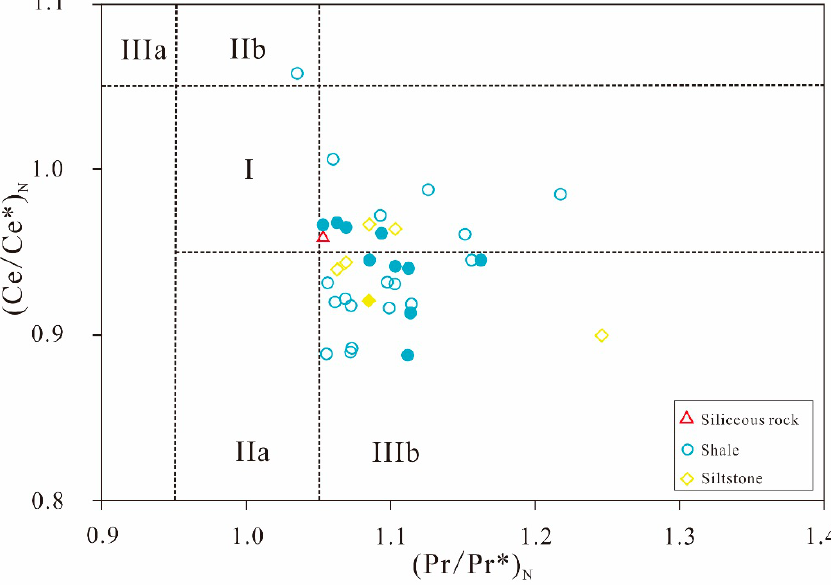
Figure 7. Cross plots demonstrating the relationship between Pr/Pr* against Ce/Ce* for SQ-1 (hollow points) and CY-1 (solid points). Base map modified from [21]. I: neither La anomaly nor Ce anomaly; IIa: positive La anomaly, no Ce anomaly; IIb: negative La anomaly, no Ce anomaly; IIIa: positive Ce anomaly; IIIb: negative Ce anomaly.